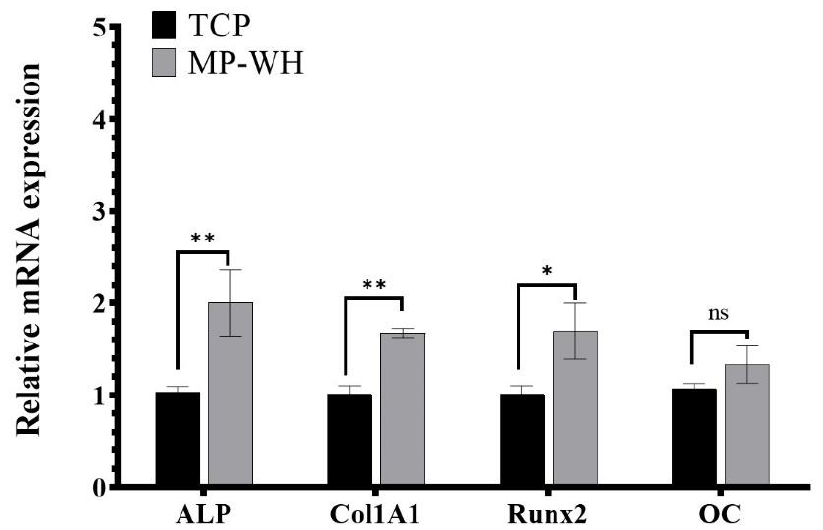
Figure 7. Relative mRNA expression of osteoblast marker genes by quantitative real-time polymerase chain reaction (qRT-PCR). Expression of each osteoblast marker gene is normalized to that of 18S rRNA, and the relative expression level was normalized to that of cells cultured on the tricalcium phosphate (TCP) 3D scaffold. Data represent the mean ± standard deviation (SD) for three samples. * p < 0.05 and ** p < 0.01 indicate significant differences from that of the TCP scaffold. ALP, alkaline phosphatase; MP-WH, marine plankton-derived whitlockite. ‘ns’ indicates not significant.